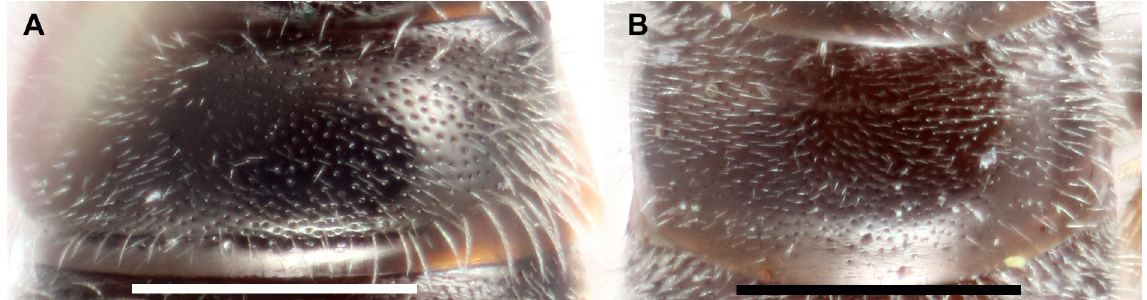
Fig. 107. T2. A . Lasioglossum coactus Cresson, 1872), ♂, apical rim deeply depressed and impunctate, contrasting with very densely punctate disc. B . L. helianthi (Cockerell, 1916), ♂, apical rim flat with gradual change in punctation across premarginal line. Scale bars = 0.5